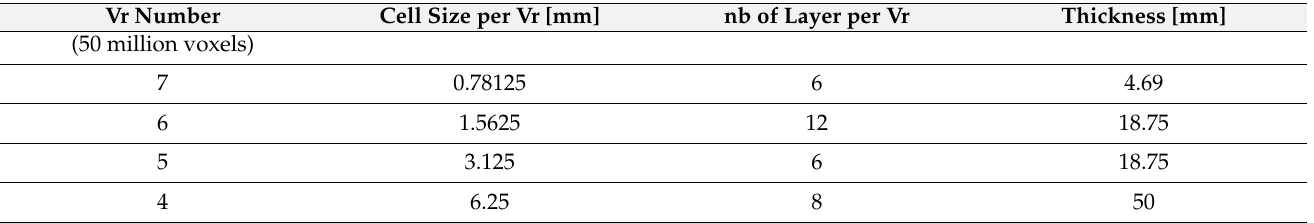
Table 1. Boundary layer definition for the mesh of 50 million voxels and 400 million voxels according to their voxel refinement (Vr)